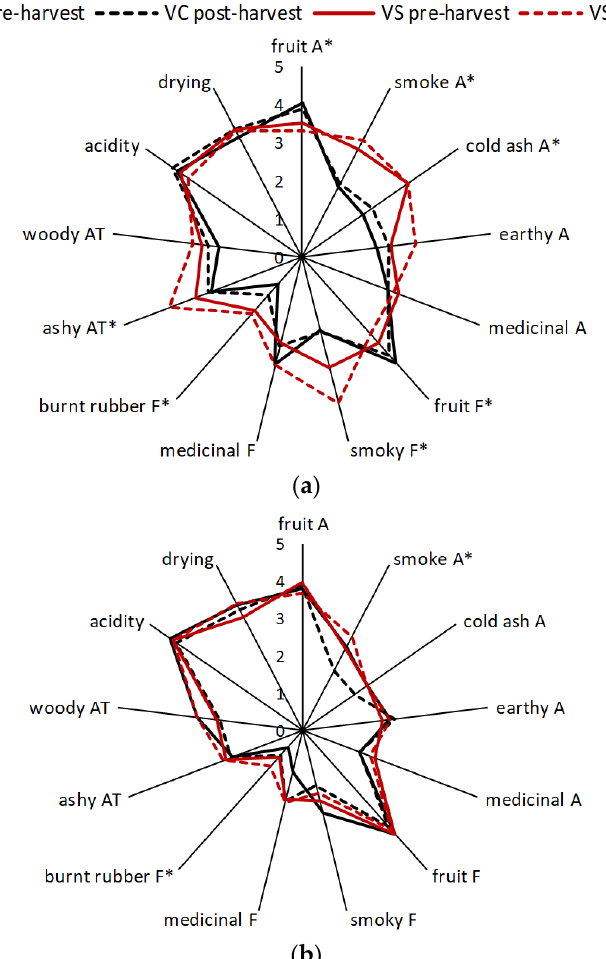
Figure 2. Sensory profiles of control (C) and smoke-affected (S) ( a ) Viognier and ( b ) Cabernet Sauvignon wines; A = aroma; F = flavor; AT = aftertaste. Values are mean intensity ratings of one wine per treatment, presented to 30 panelists; * denotes attributes for which ratings were statistically significant ( p = 0.05, two-way ANOVA). Table 2. Concentrations of volatile phenols (µg/L) in wines (and acid hydrolysates of wine) made from control (C) and smoke-exposed (S) grapes.